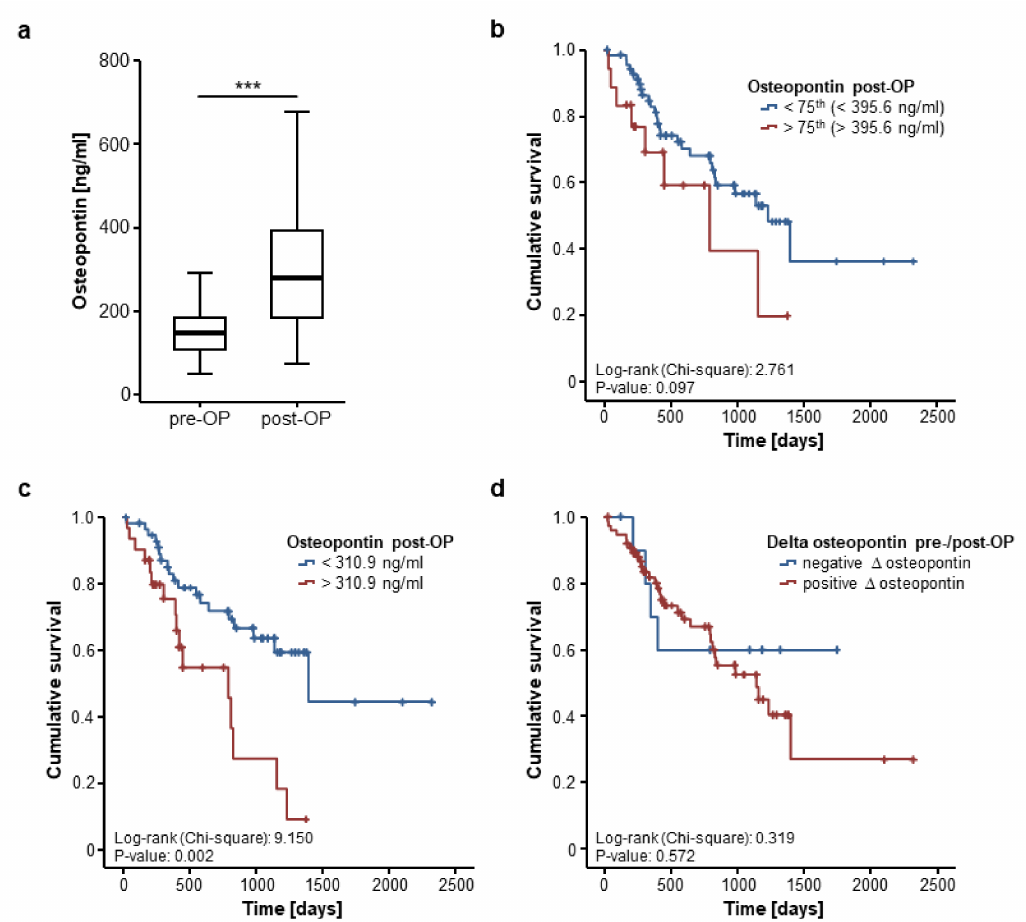
Figure 4. Postoperative osteopontin serum levels are associated with the patients’ prognosis. ( a ) Circulating osteopontin levels are significantly higher after tumour resection compared to preoperative levels (Wilcoxon signed-rank test, p (***) < 0.001); ( b ) Patients with postoperative osteopontin serum levels above the 75th percentile display a trend towards an impaired prognosis (log-rank test, p = 0.097); ( c ) At our ideal cut-off of 310.9 ng/mL, postoperative osteopontin concentrations significantly discriminate between patients with good or poor prognosis (log-rank test, p = 0.002); ( d ) Longitudinal changes of osteopontin serum concentrations before and after tumour resection are unsuitable to predict patients’ outcome (log-rank test, p =